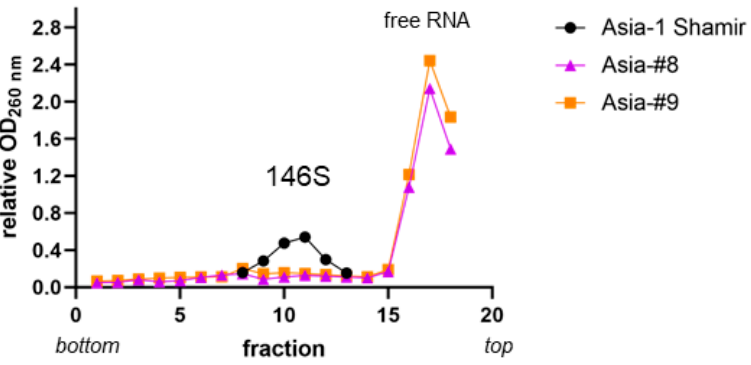
Figure 2. Sucrose gradient profiles of Asia-1 Shamir, Asia-#8 and Asia-#9. Virus strains Asia-#8 and Asia-#9 were grown in BHK-2P and the wild-type isolate Asia-1 Shamir was grown in adherent BHK-21 cells. The harvested virus was concentrated by ultracentrifugation and sedimented through a 15–45% sucrose density gradient. The peaks corresponding to RNA in 146S particles and free RNA are